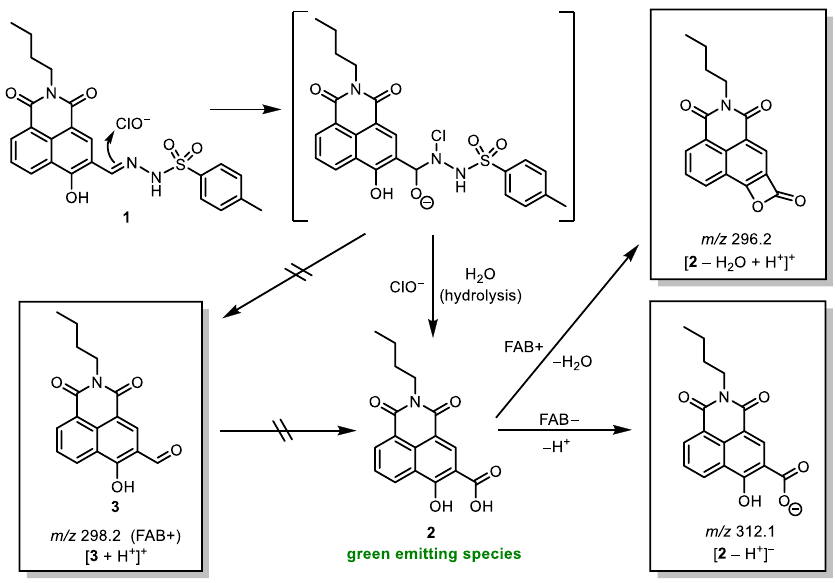
Scheme 2. Proposed mechanism for the reaction of 1 with ClO −